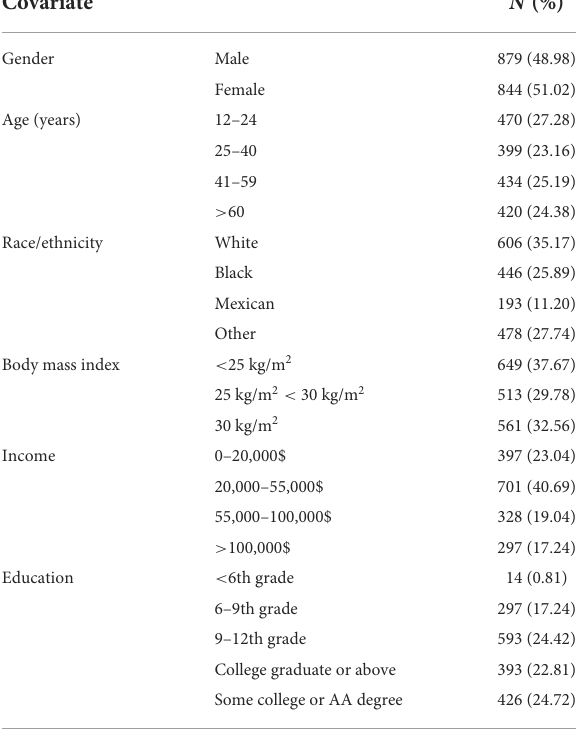
TABLE 1 Characteristics of study population ( n =